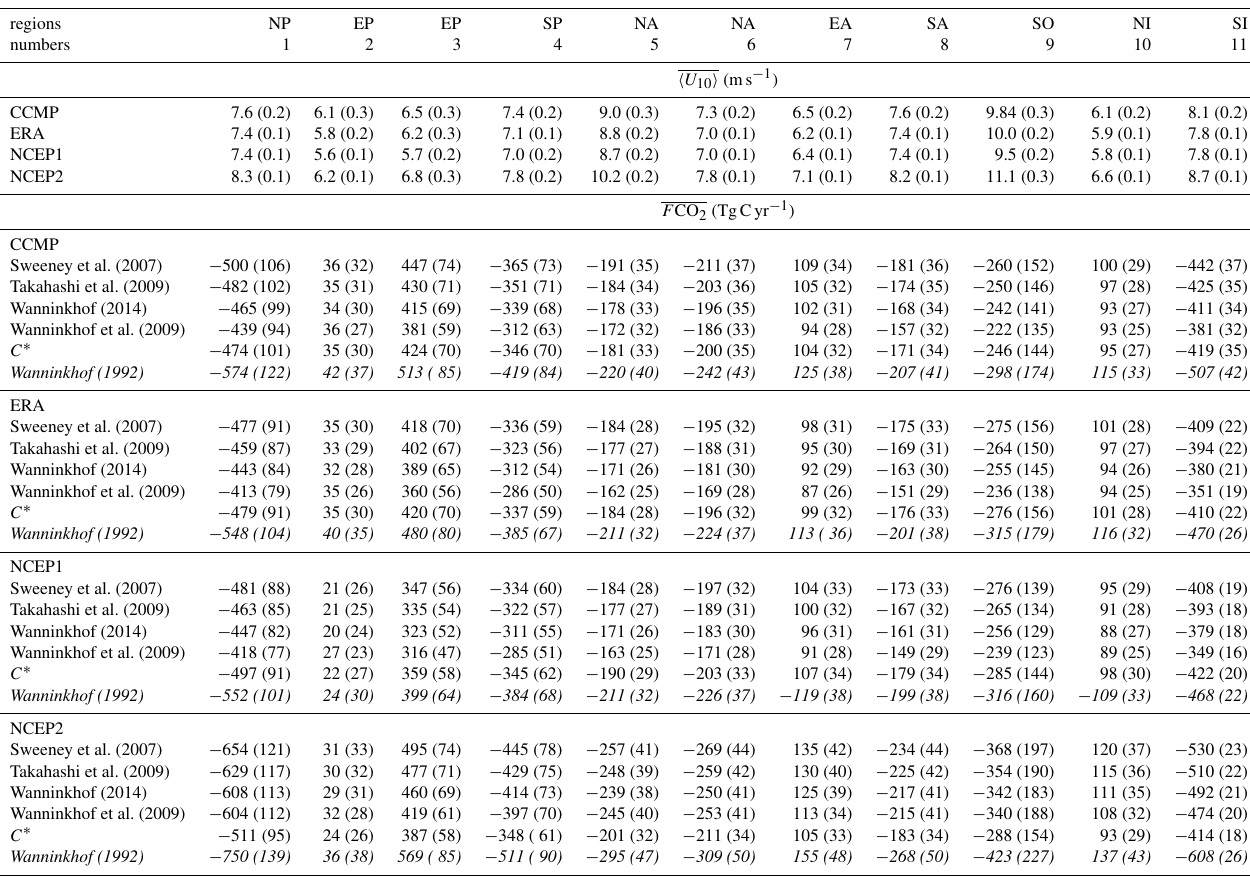
Table A1. 21 year mean U 10 ( (cid:104) U 10 (cid:105) , ms − 1 ) and F CO 2 ( F CO 2 , TgCyr − 1 ) in the 11 oceanic RECCAP regions calculated using the different global k relationships combined with four different wind products. C ∗ refers to F CO 2 calculated with a quadratic k relationship where c is recalibrated for each wind product to fit a global average k value of 16cmh − 1 for the period of the study (1991–2011). Following the RECCAP nomenclature, NP stands for North Pacific, EP: Equatorial Pacific, SP: South Pacific, NA: North Atlantic, EA: Equatorial Atlantic, SA: South Atlantic, SO: Southern Ocean, NI: North Indian Ocean and SI: South Indian Ocean. Results using the k parametrization of Wanninkhof (1992), which are excluded from our analysis, are represented in italic. The interannual variability is reported as standard deviations between